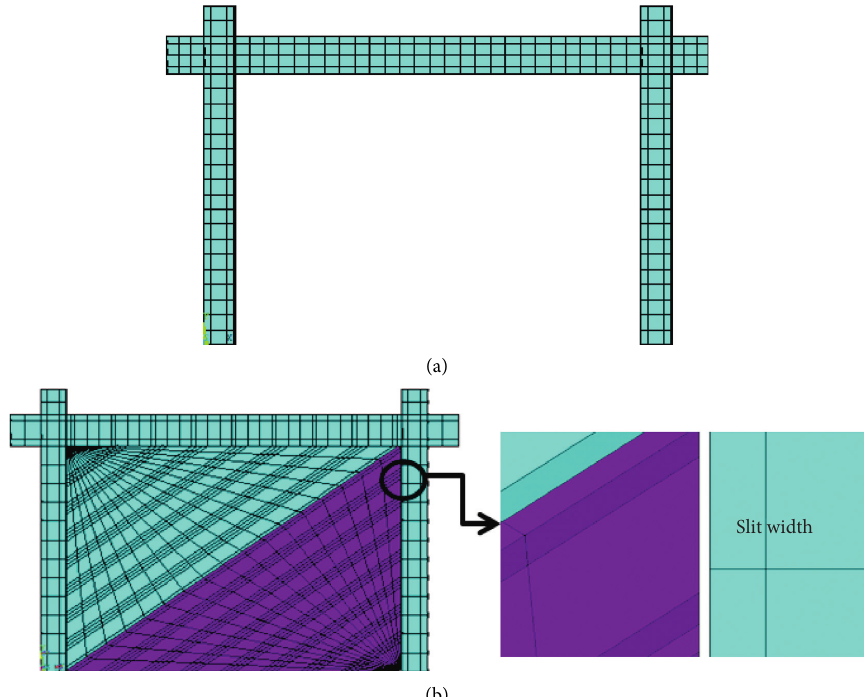
Figure 7: Finite element models. (a) Nonductile RC frame (ND-1). (b) Reinforced frame (ND-2) with slit width (10mm).